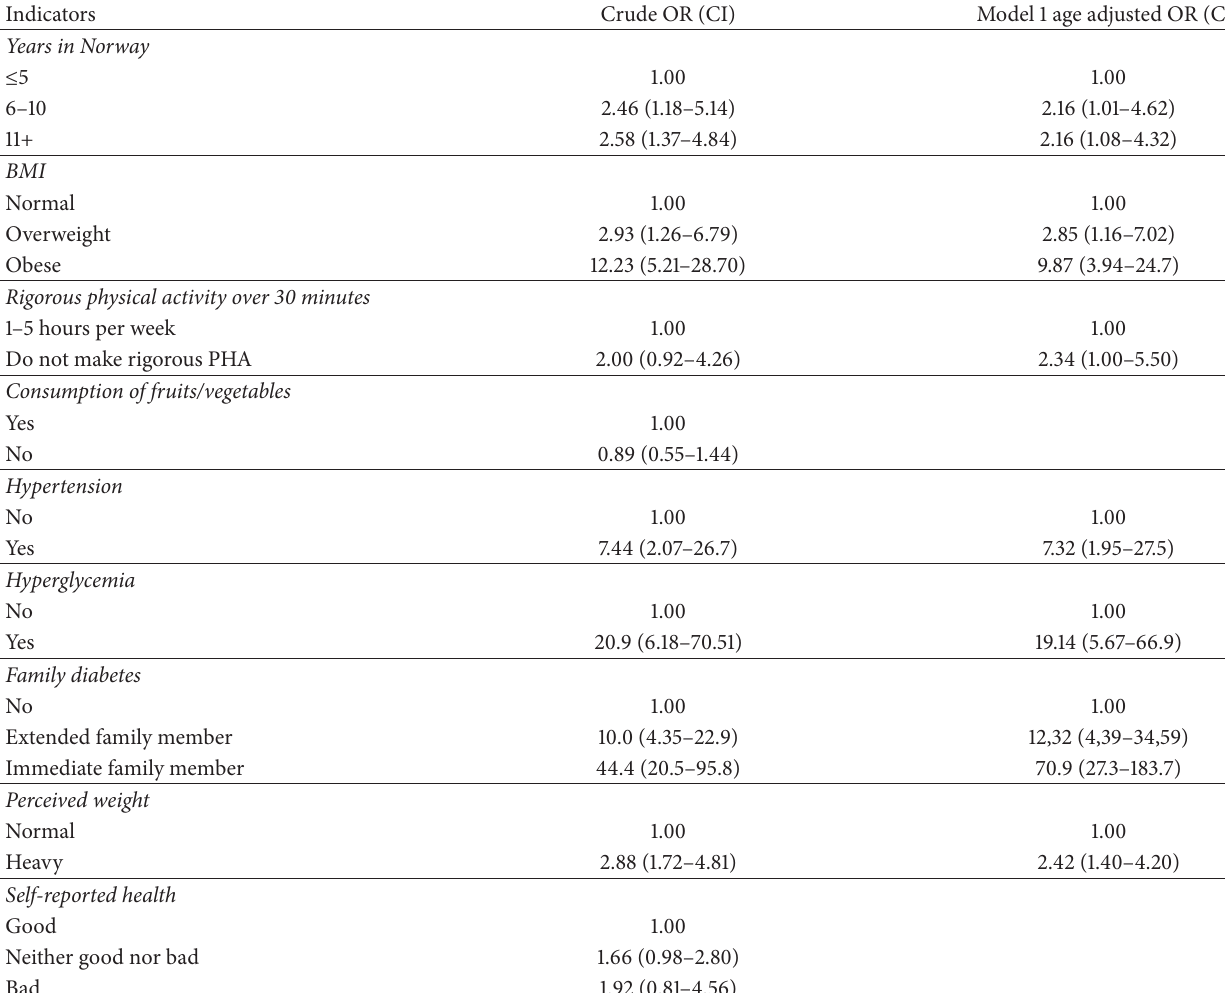
Table 3: Factors associated with diabetes risk among Somali women in